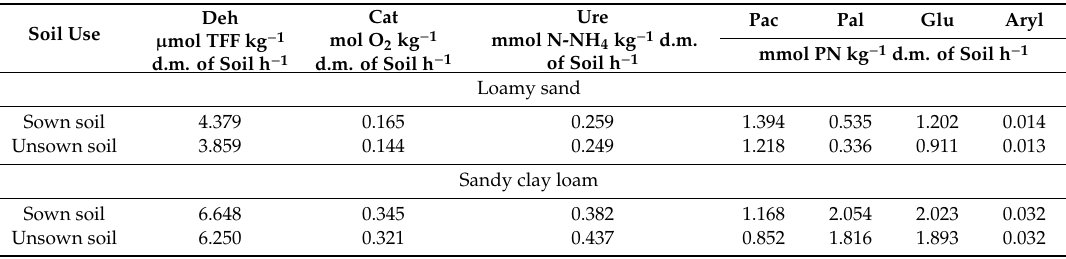
Table 9. Enzyme activity in non-contaminated